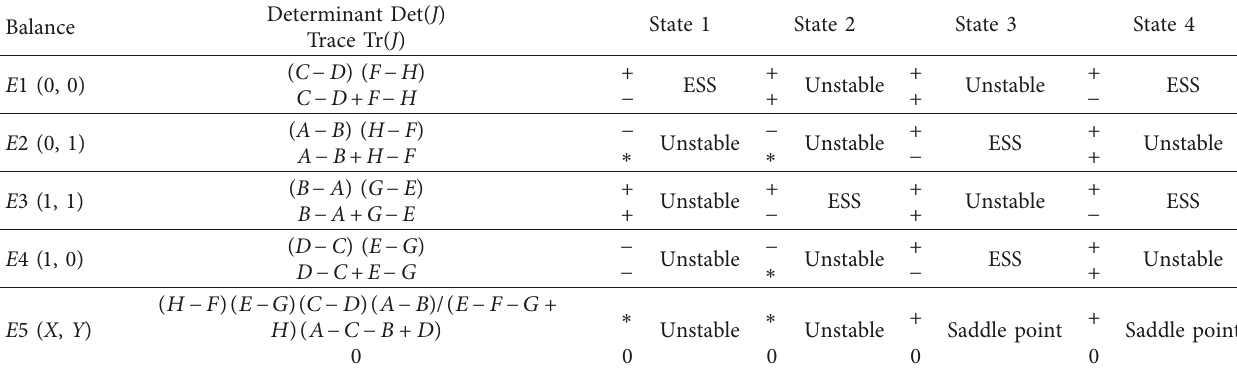
Table 4: Determinant Det( J ) and trace Tr( J ) of the equilibrium point under various state conditions.